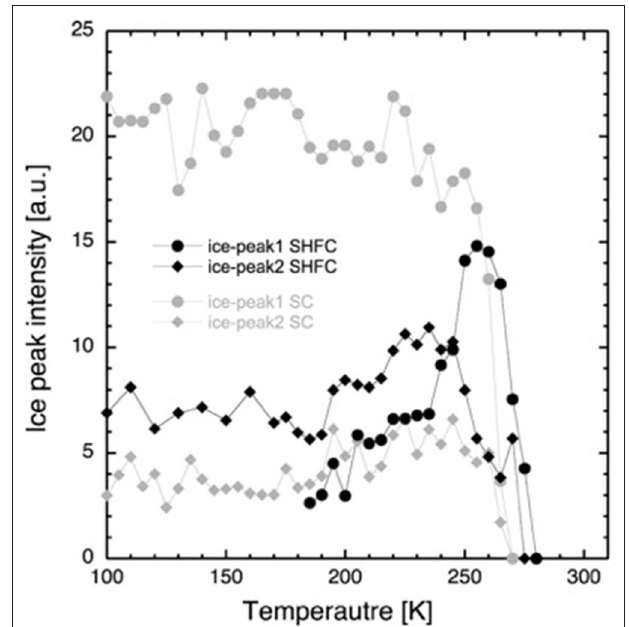
FIGURE 4 | Integrated intensity of the diffraction peaks at Q = 1.61 Å − 1 ( ice peak 1 , circles) and Q = 1.71 Å − 1 ( ice peak 2 , diamonds) after flash cooling upon heating from 100 to 300K (SHFC protocol, black data points) and during subsequent slow cooling from 300 to 100K (SC protocol, gray data points). The time interval between successive data points was